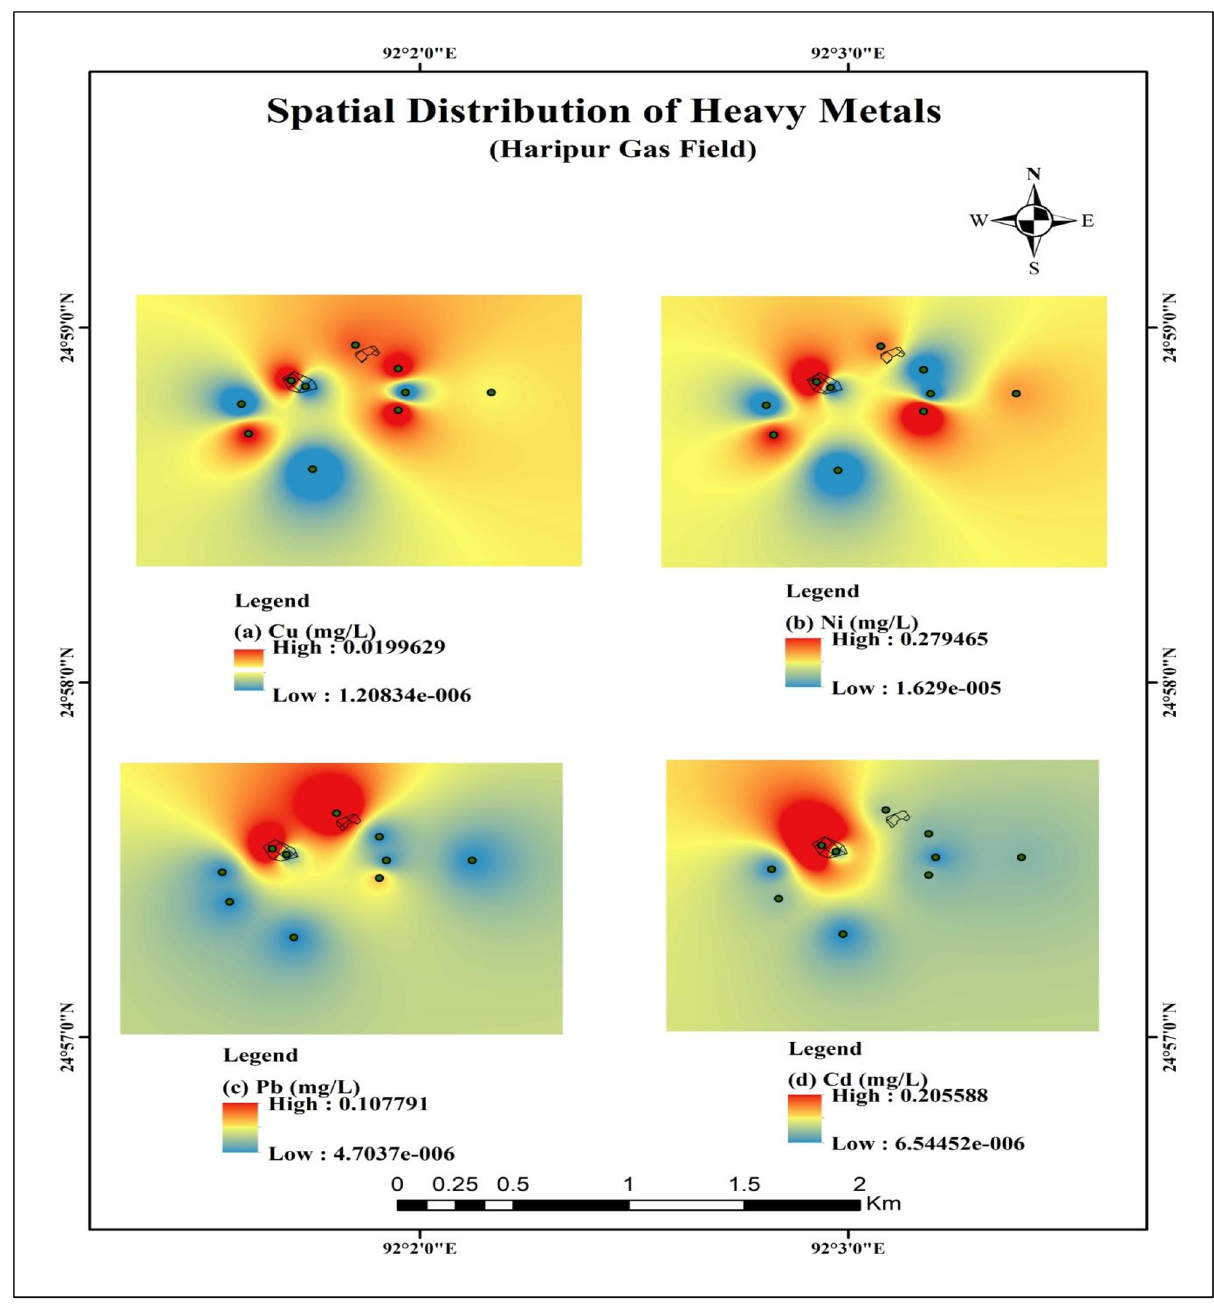
Figure 4. The spatial distribution map of toxic metals in the